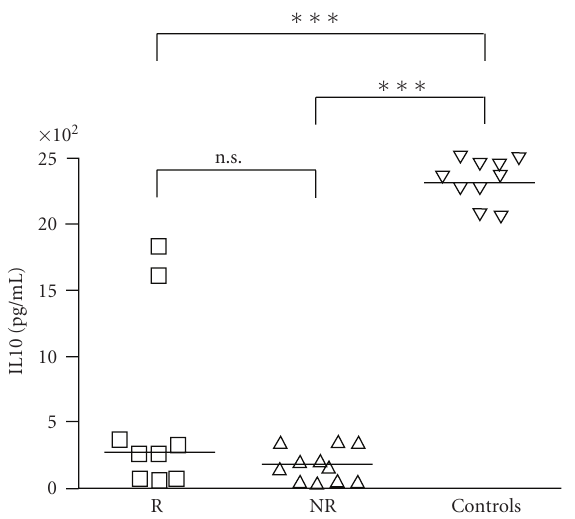
Figure 4: Both in patients developing left ventricular remodeling after myocardial infarction (R, n = 20) and in patients not devel- oping left ventricular remodeling (NR, n = 20) lymphomonocyte production of IL10 in response to LPS was reduced in comparison with controls on day 1 after reperfusion ( ∗∗∗ P < . 001).